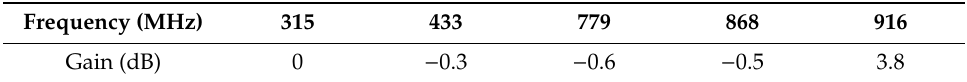
Table 6. Gain at di ff erent frequencies.